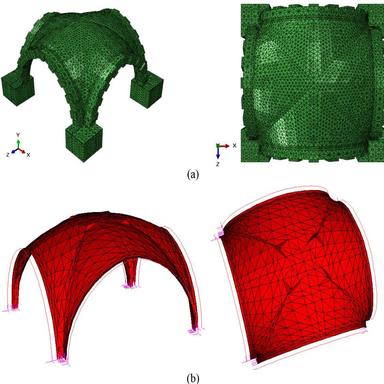
FE discretization adopted to perform numerical simulations in Abaqus (a) and with the SQP approach (b).